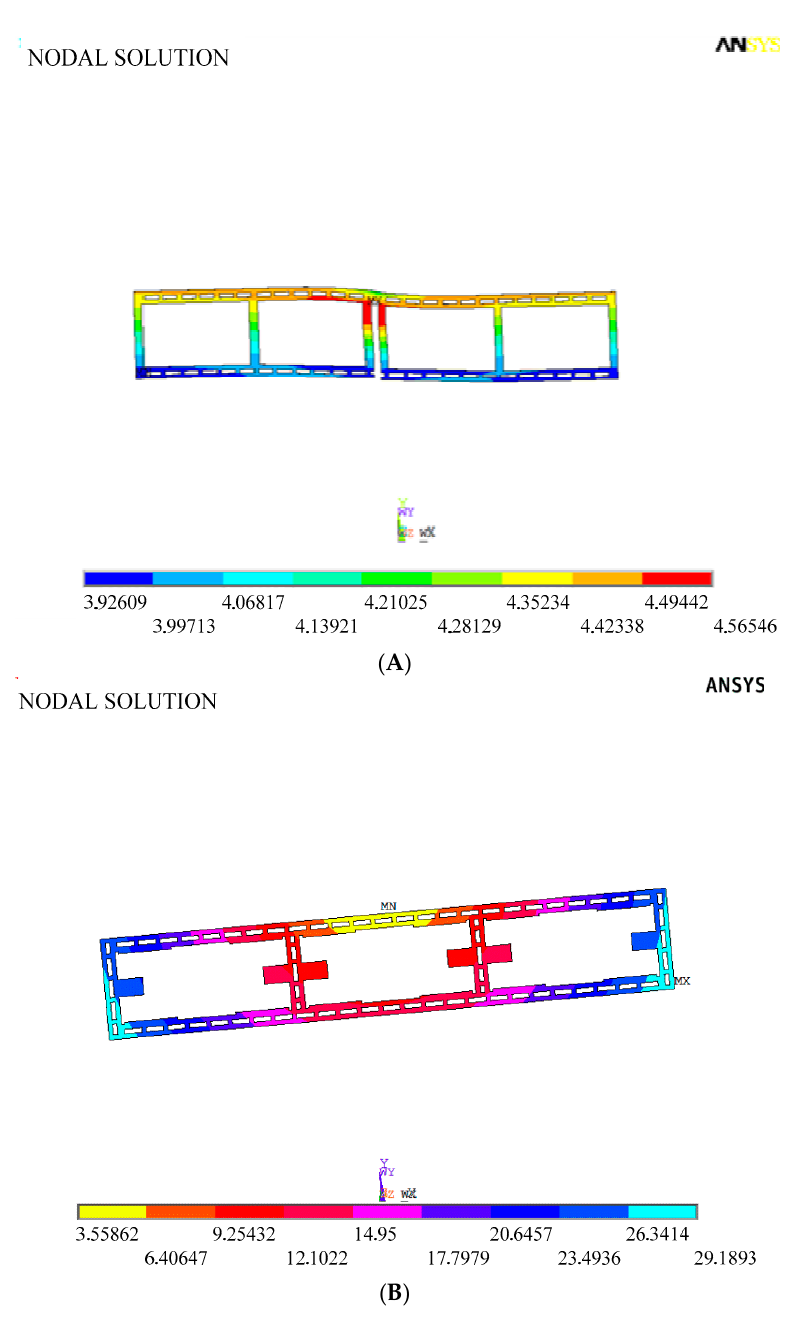
Figure 6. Sense frame displacements in the anti-phase drive mode. ( A ) Improved structure; ( B ) Former structure.